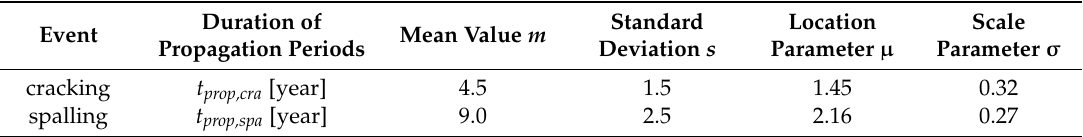
Table 5. Duration of propagation periods t prop linked to the events of cracking and spalling according to data presented in [7].